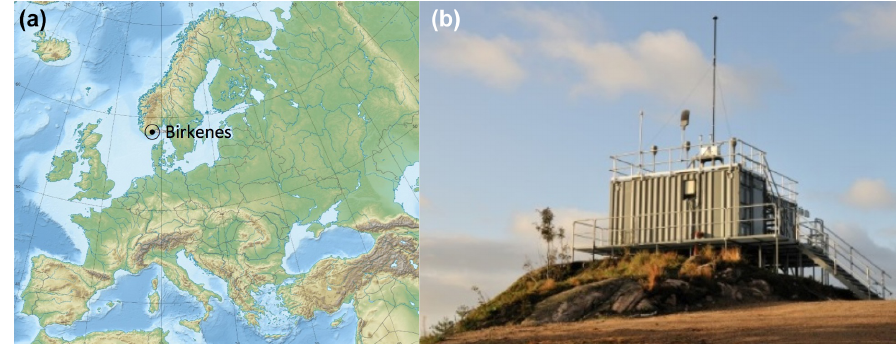
Figure 1. Location of Birkenes Observatory (a) and a view of the observatory (b)